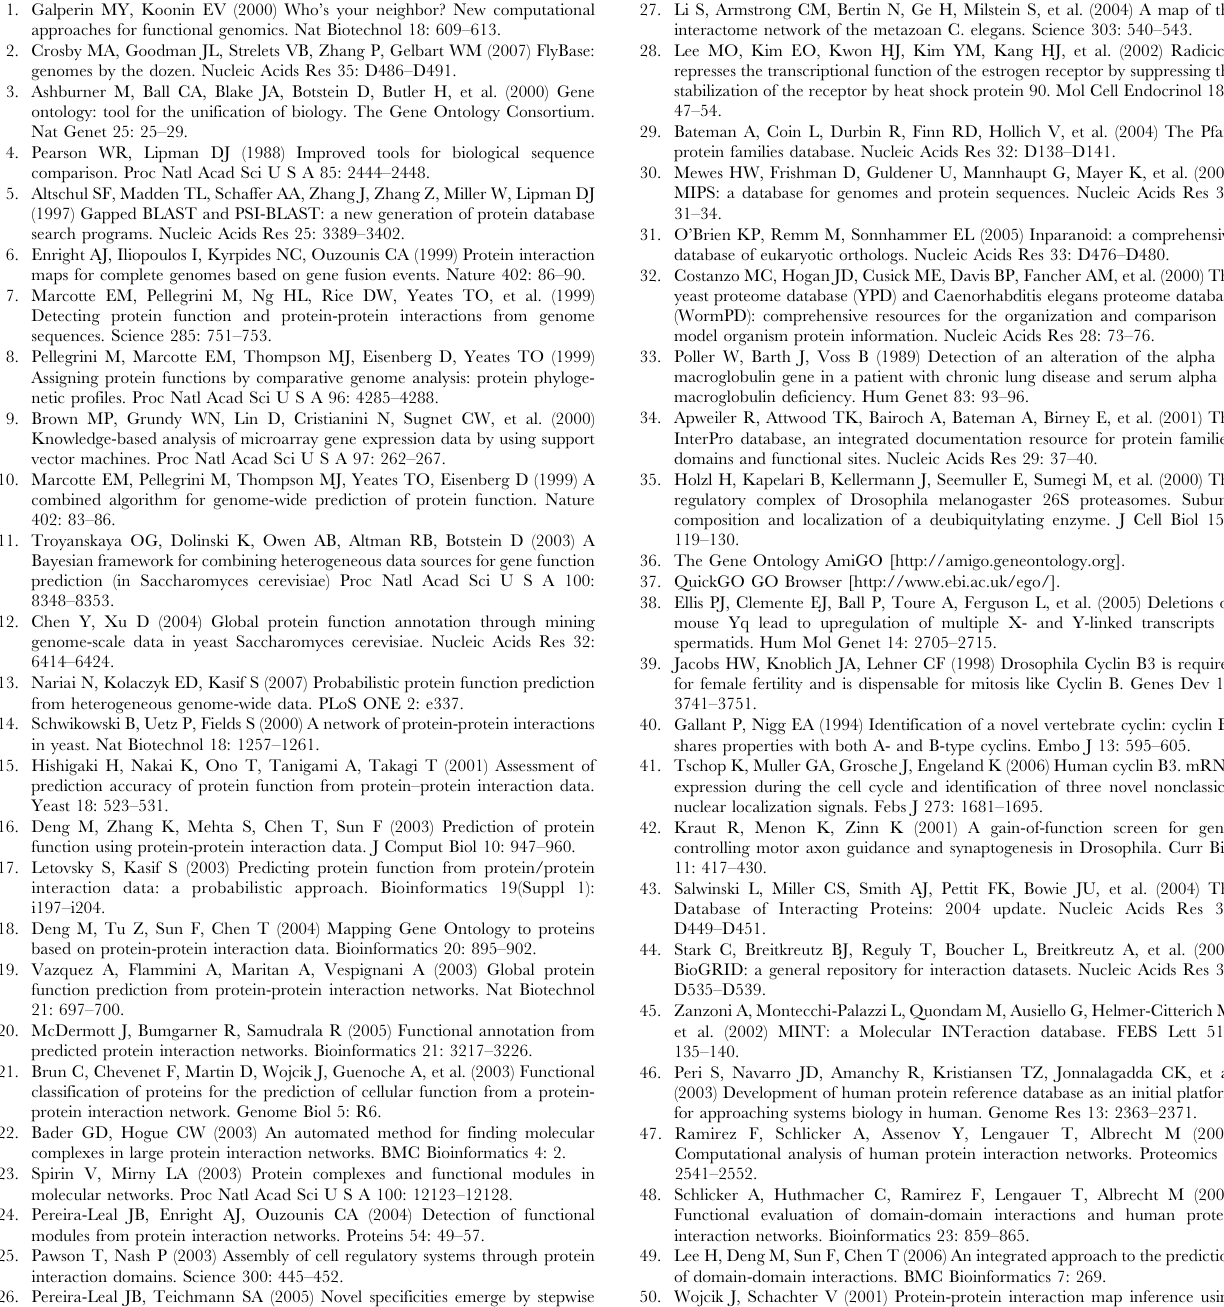
database of protein families, domains and functional sites in which identifiable features found in known proteins can be applied to unknown protein sequences. IntAct is by Giot et al. The following is a list of evidence codes used in the